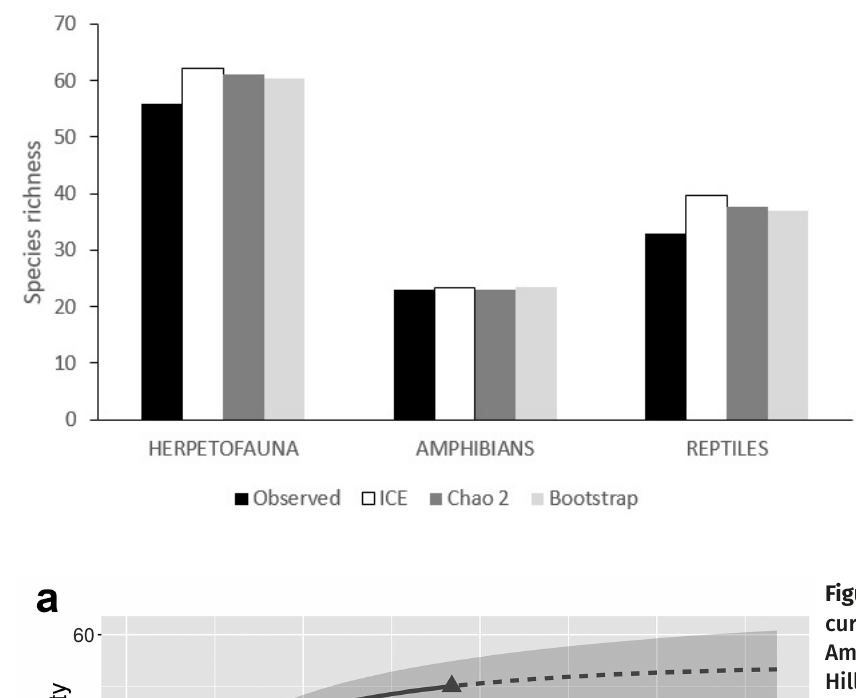
Figure 3. Species-accumulation curves for Herpetofauna (a), Amphibians, and reptiles (b). Hill A: Amphibians of the Hill, Hill R: Reptiles of the Hill, Pedim A: Amphibians of the Pediment, Pedim R: Reptiles of the